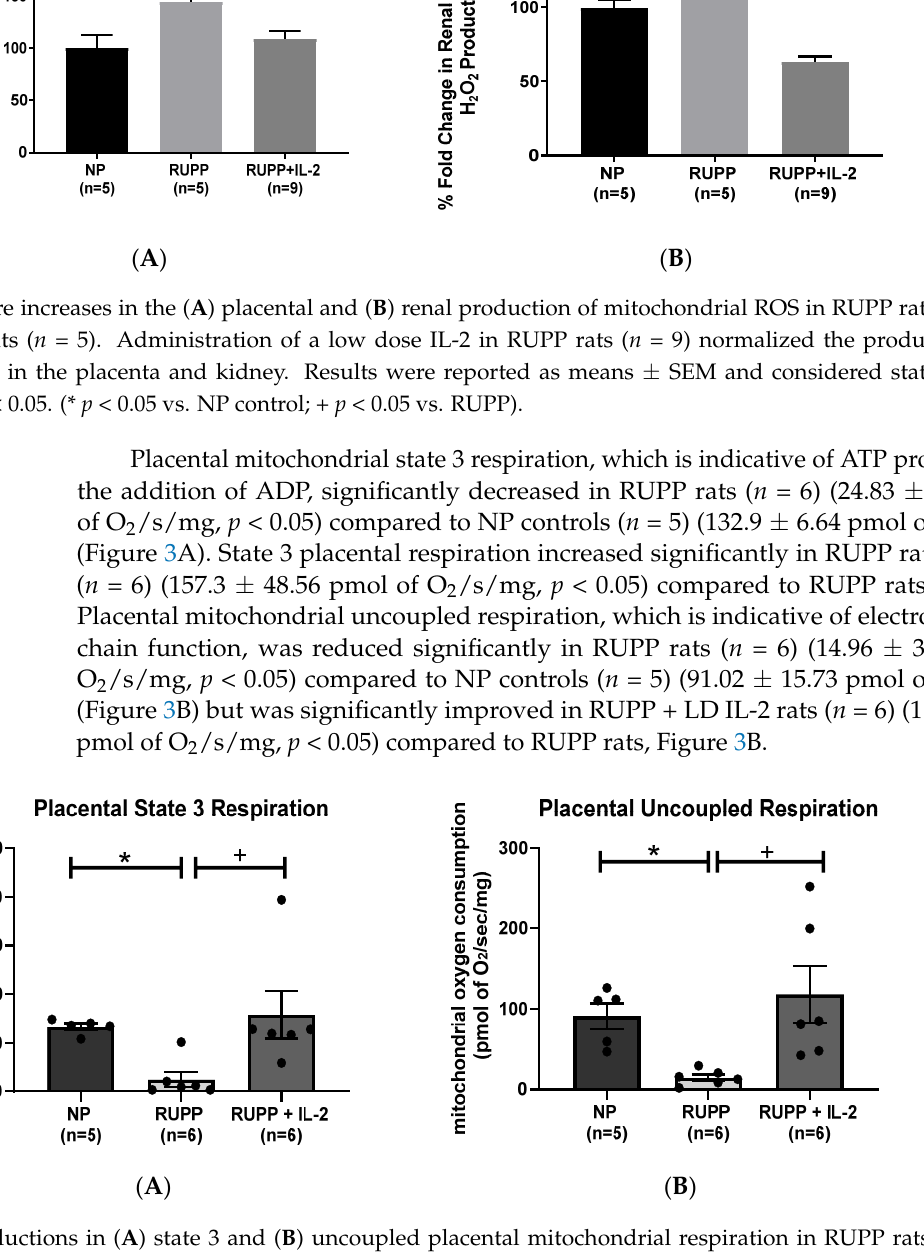
( B ) Figure 4. ( A ) State 3 and ( B ) uncoupled renal mitochondrial respiration were reduced in RUPP rats ( n = 5) compared to NP rats ( n = 5), but were normalized in RUPP + LD IL-2 rats ( n = 6). Results were reported as means ± SEM and considered statistically significant when p < 0.05. (* p < 0.05 vs. NP control; + p < 0.05 vs. RUPP). ( A ) ( B ) Figure 5. ( A ). Placental RCR (state 3/state 4) was reduced in RUPP ( n = 6) compared to both NP rats ( n = 5) and RUPP + LD IL-2 rats ( n = 6). ( B ). Renal RCR (state3/state 4) was reduced in RUPP rats ( n = 5) compared to NP rats ( n = 5).There was no significant difference in RCR demonstrated in RUPP + LD IL-2 rats ( n = 5) compared to RUPP rats. Results were reported as means ± SEM and considered statistically significant when p < 0.05. (* p < 0.05 vs. NP control; + p < 0.05 vs. RUPP). P l ace n t a l M i t o c hond r i a l RCR ( S t a t e 3 / S t a t e 4 )